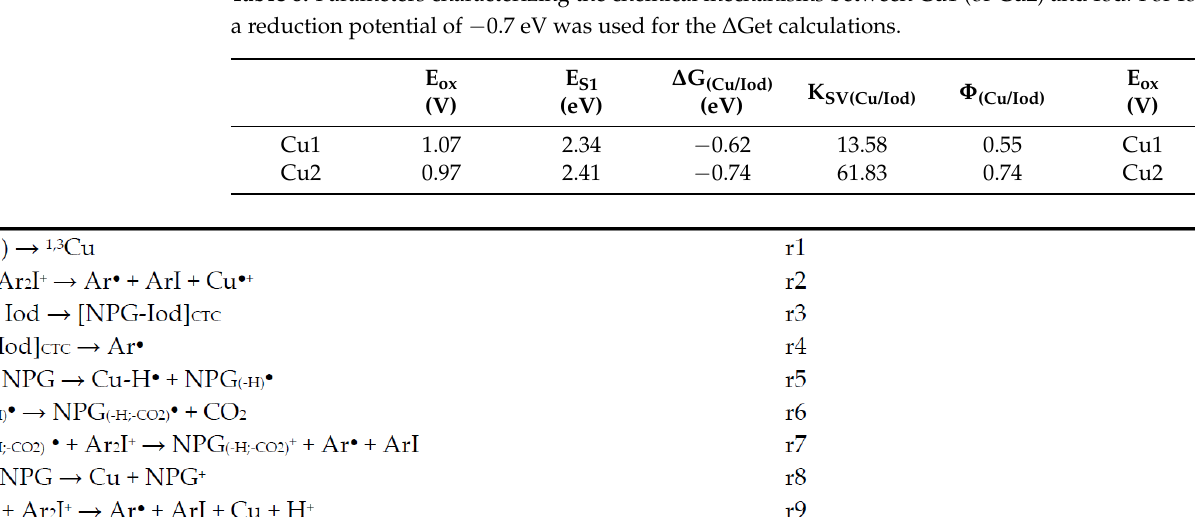
Scheme 3. Proposed chemical